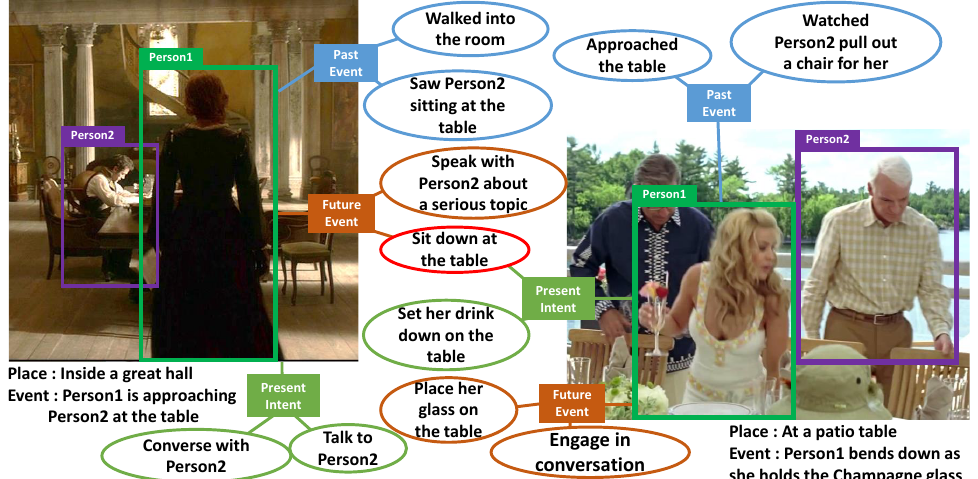
Figure 1. Illustration of visual commonsense generation. Given a person in an image and a corre- sponding textual event, an agent is required to generate (1) what needed to happen before , (2) what is the current intent of person, and (3) what will happen after